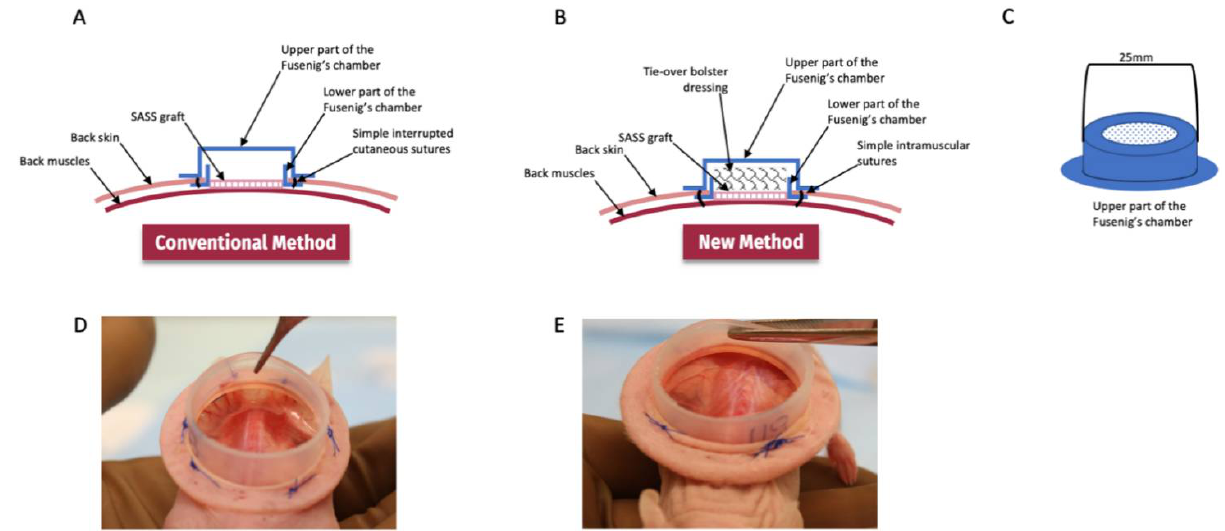
Figure 6. Schematic view of the two models studied. ( A ) The conventional method included the fixation of the chamber directly to the skin by simple interrupted cutaneous sutures and no addi- tional dressing is added on the skin graft in the Fusenig’s chamber. ( B ) The new method included intramuscular sutures for the fixation of the Fusenig’s chamber and the addition of a tie-over bolster dressing to cover the skin graft. ( C ) Diagram of the upper part of the Fusenig’s chamber which is added after grafting to protect the graft. ( D ) Without intramuscular stitches the Fusenig’s chamber is not properly secured whereas with ( E ) intramuscular stitches, the chamber is tightly secured to the muscles limiting displacement.